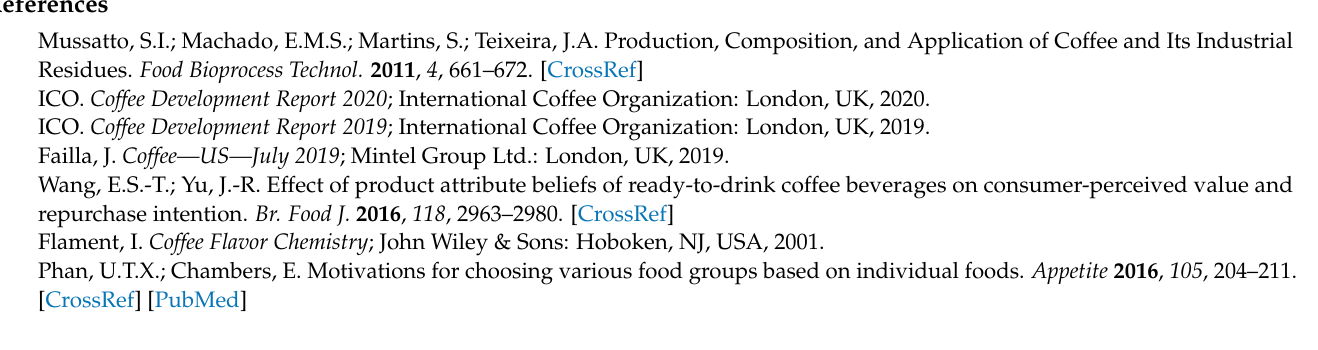
Figure S2: Scheme of fractionation of highly predictive features, Figure S3: 1 H NMR experiments of 3- O -feruloylquinic acid, Figure S4: 1 H and 13 C NMR experiments of 5- O -feruloylquinic acid, Figure S5: MS/MS fragmentation of (A) feature 2.68_353.1, 3-caffeoylquinic acid, (B) feature 3.22_353.1, 5-caffeoylquinic acid, (C) feature 3.36_353.1, 4-caffeoylquinic